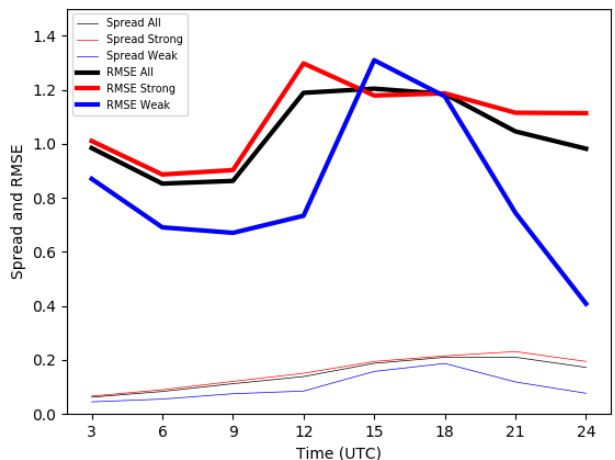
Figure 11. Aggregated time series of the spread (standard devia- tion) and skill (RMSE of the ensemble mean) averaged over the full SOP1 period (black) and over weakly (blue) and strongly forced weather regimes